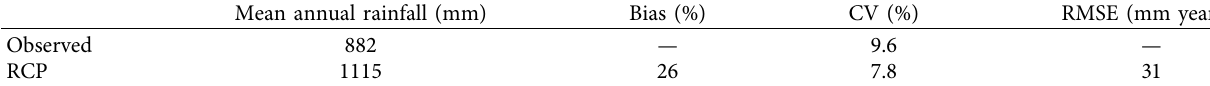
Table 2: Accuracy of rainfall from RCP data.